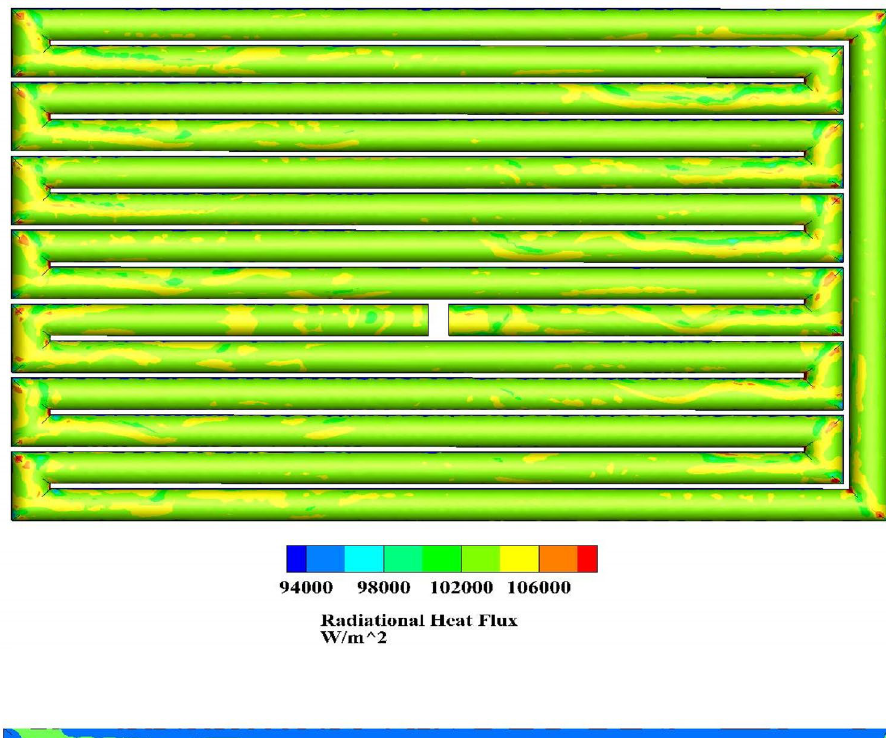
Fig. 14 CFD result of tem- perature distribution on WCP hot-side (degree of